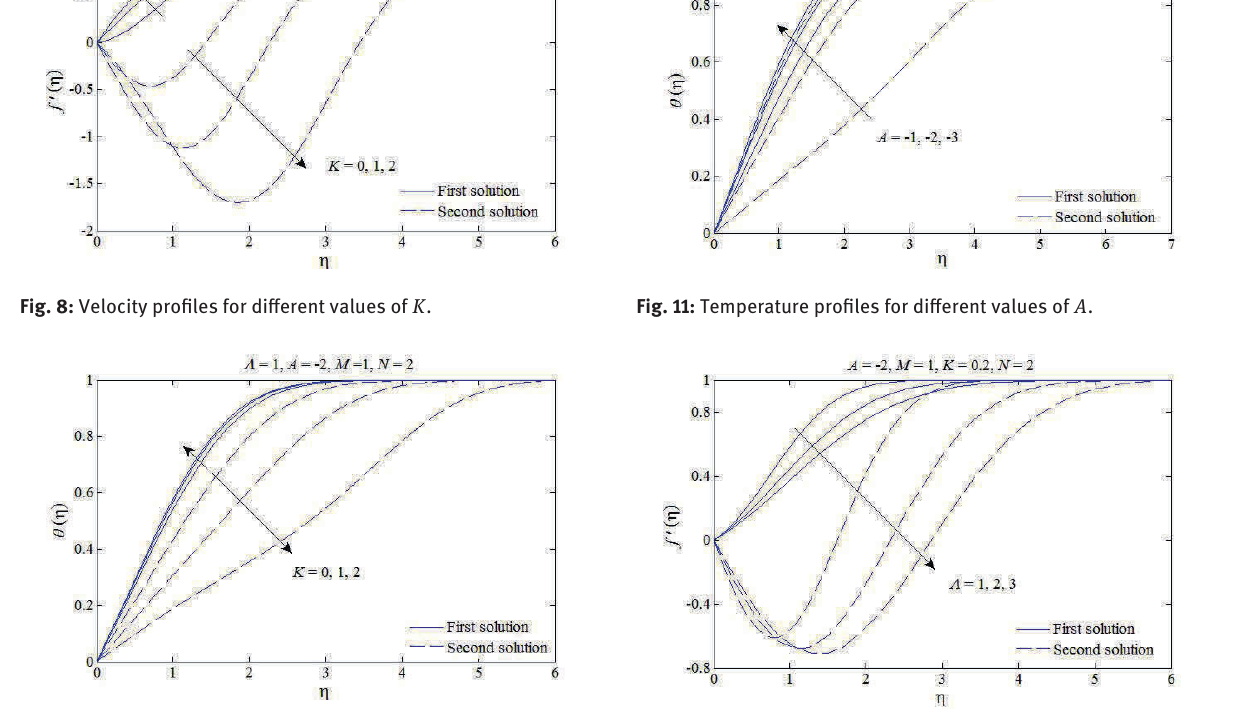
Fig. 12: Velocity profiles for different values of Λ .